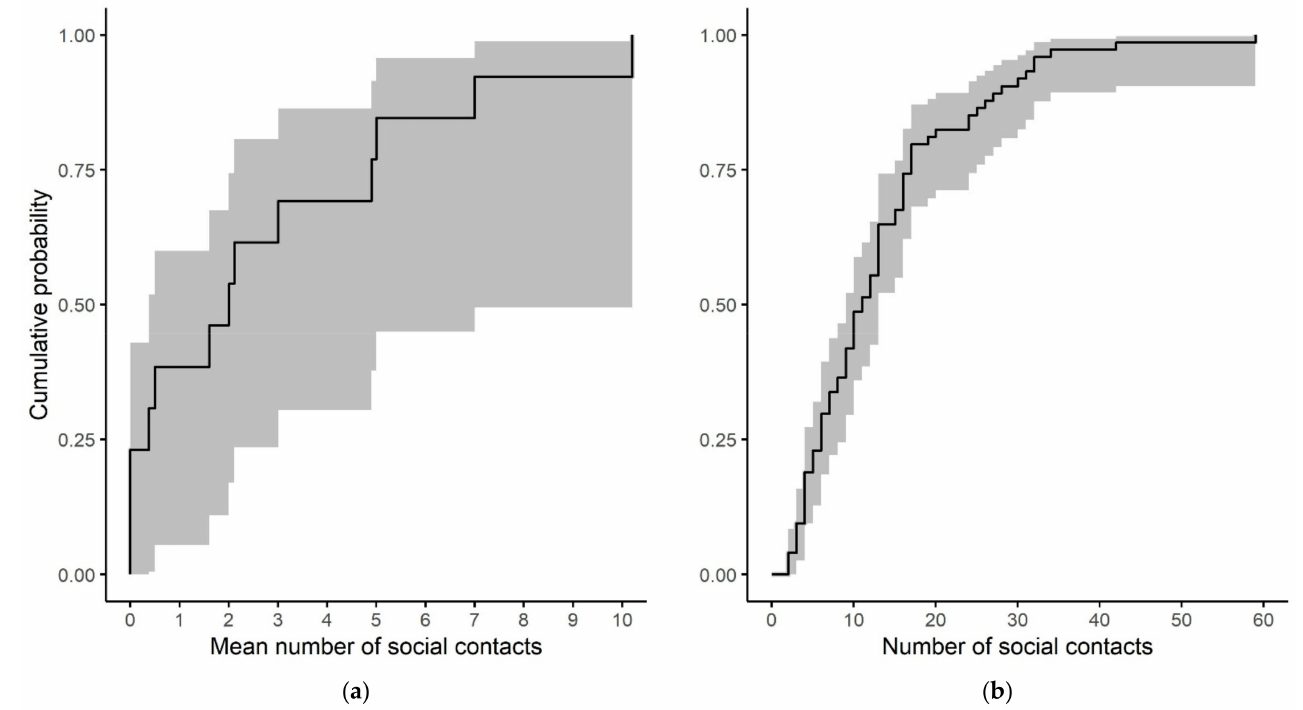
Figure A2. ( a ) Mean number of social contacts per CAMP-remote participant per day (n = 13). ( b ) Number of social contacts per adult, female participants (20–49 years) per day in a community in rural coastal Kenya collected by Kiti et al. (n = 74) [16]. The definition of contact for Kiti et al.’s study was anyone with whom they had physical contact [16], while the definition for the CAMP-remote study was anyone with whom they had spent an hour or